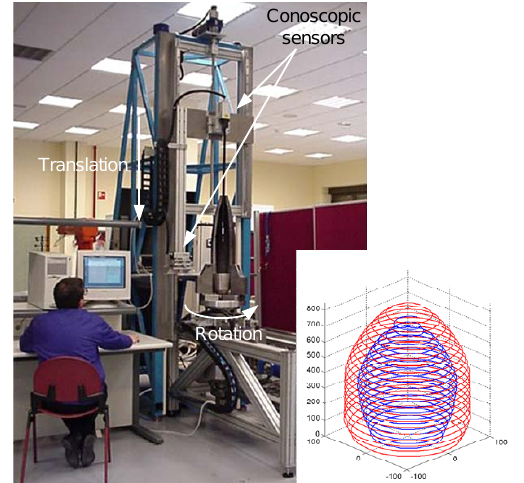
Figure 5. System for measuring the internal and external surfaces in a solid of